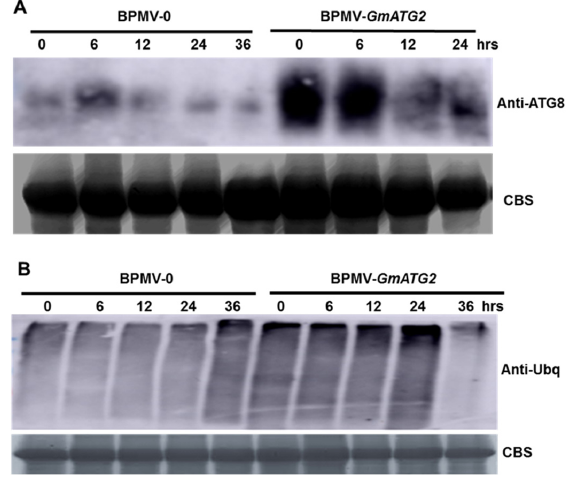
Figure 3. Silencing of GmATG2 impaired autophagic degradation. ( A ) Comparison of the accumula- tion level of the ATG8 protein between the BPMV-0 and GmATG2- silenced plants; ( B ) comparison of the level of the ubiquitinated proteins between BPMV-0 and BPMV- GmATG2 plants. Protein samples were extracted from the BPMV-0 and BPMV- GmATG2 plants, respectively, at 0 min, 6 h, 12 h, 24 h and 36 h post dark treatment. The experiments were repeated at least 2 times with similar results. At least 3 plants were used in each